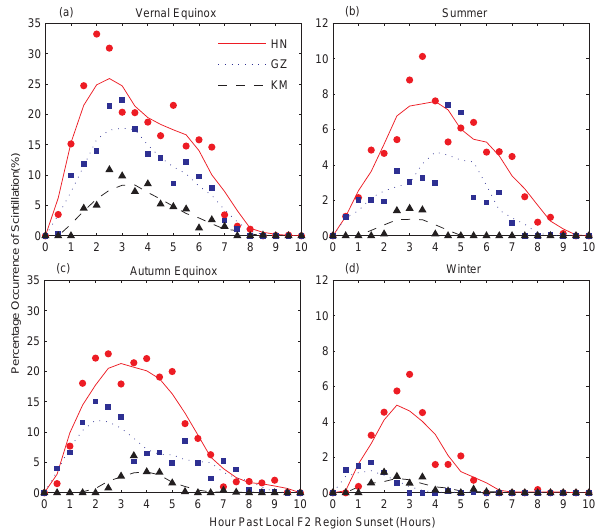
Figure 3. The nocturnal and seasonal variations of the percentage occurrences of scintillation observed at HN, GZ and KM in 2013. The time in the x axis is hours past the F2-region sunset. The time beyond 4h past the F2-region sunset belongs to the